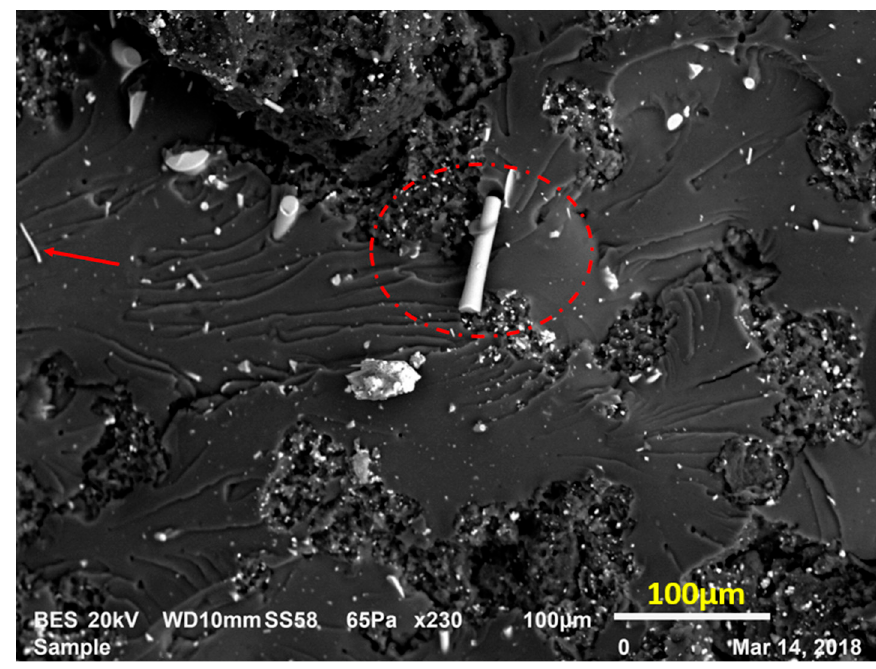
Figure 10. Fiber pull-out in LRAL group composites.